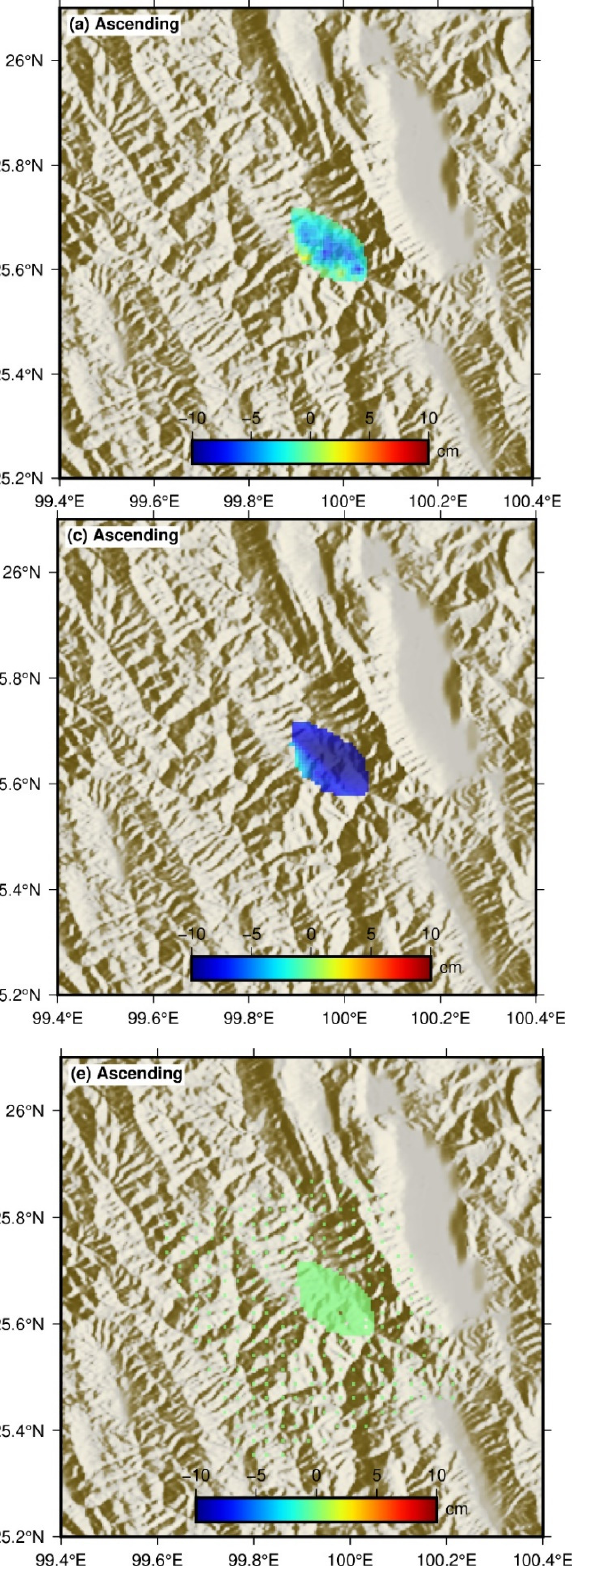
Figure 5. Coseismic Sentinel-1A observations and the model fitting of the distributed slip inversion: ( a , b ) coseismic Sentinel-1A observations of the ascending and descending; ( c , d ) simulation of the ascending and descending; ( e , f ) residual error of the ascending and descending.